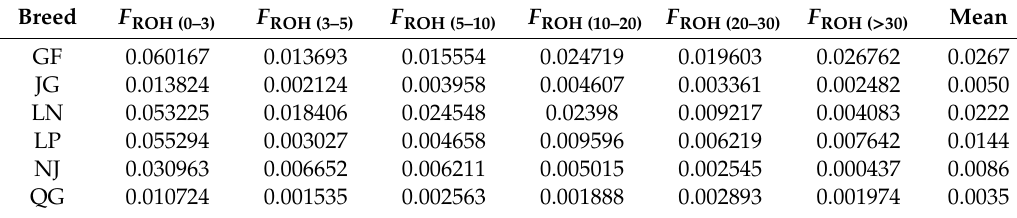
Table 3. Estimated inbreeding levels at each cut-o ff point of runs of homozygosity.